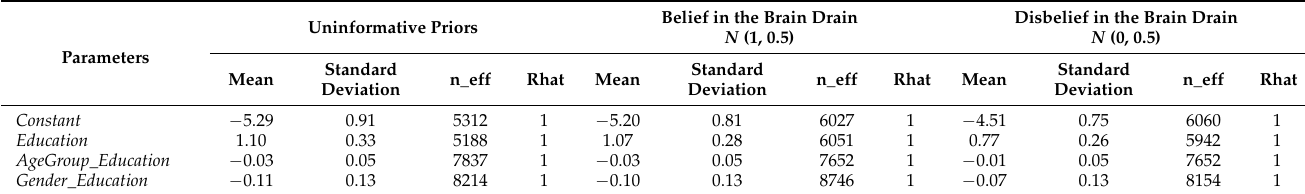
Table 3. Model 2′s simulated posterior coefficients.